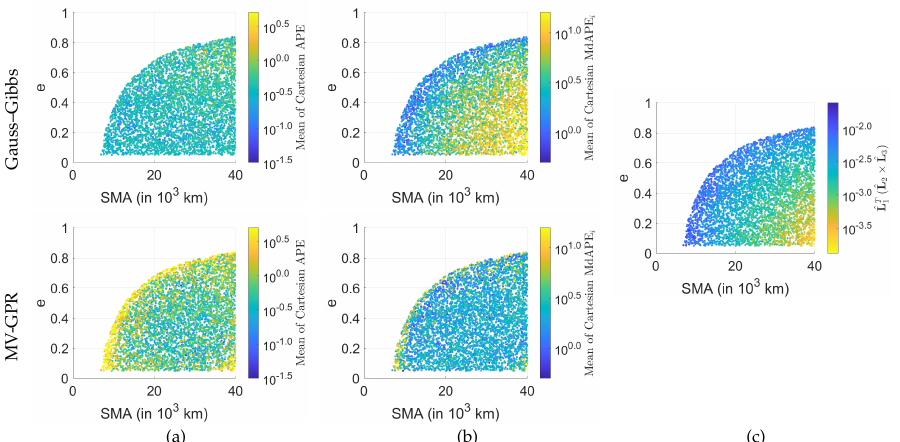
Figure 6. Effects of orbit shape on GPR predictions for Case C: ( a ) average of the Cartesian APE of the GPR solution given perfect measurements, ( b ) the average MdAPE i given noisy measurements, ( c ) the coplanarity of the lines-of-sight. Colorbars represent range for the 99% of points to increase readability in the presence of